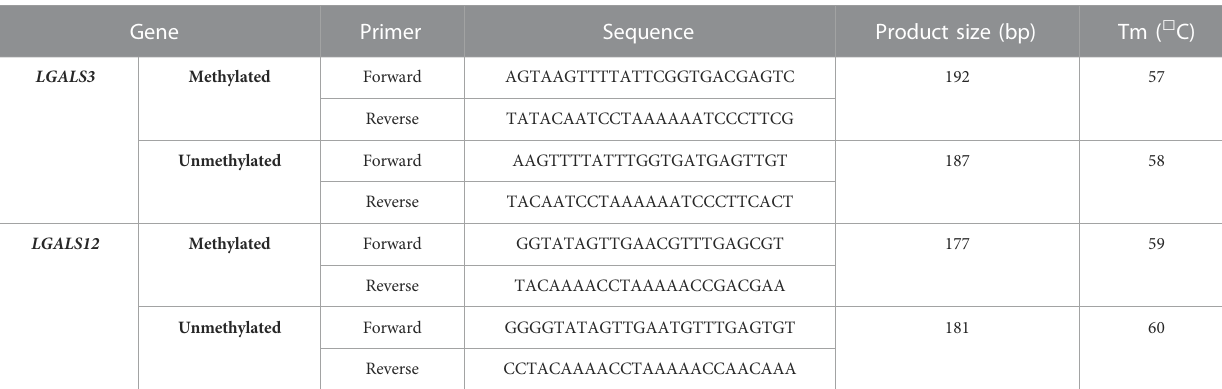
TABLE 2 Pro fi le of primers used in MSP.